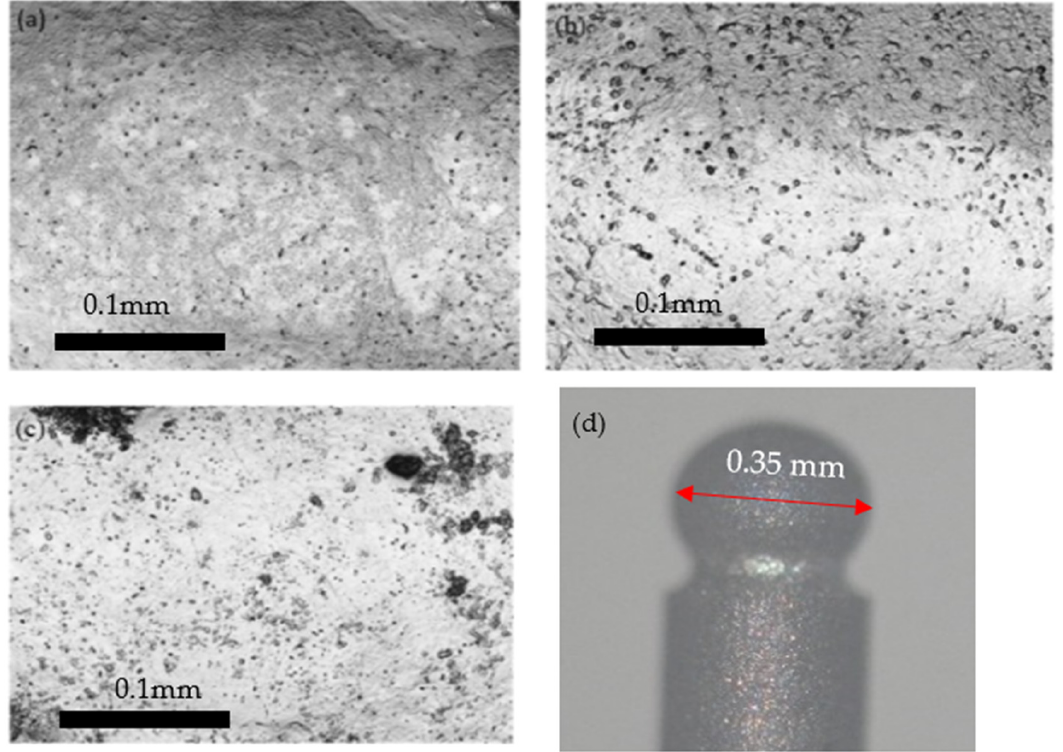
Figure 5. Preliminary tests of ECM work surface with spherical tooltip of ( a ) 150 μ m, ( b ) 250 μ m, ( c ) 350 μ m, and ( d ) WEDG dressed profile of the spherical tooltip with a diameter of 350 μ m.